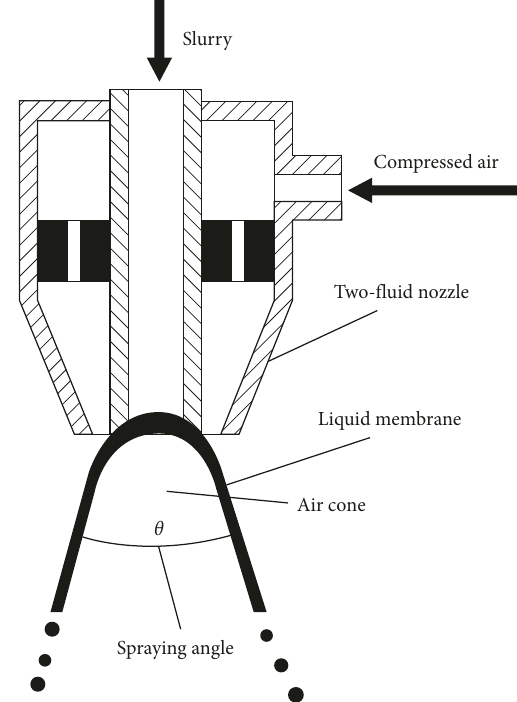
Figure 4: Schematic diagram of two-fluid nozzle with the external mix and formation of droplets (adapted from